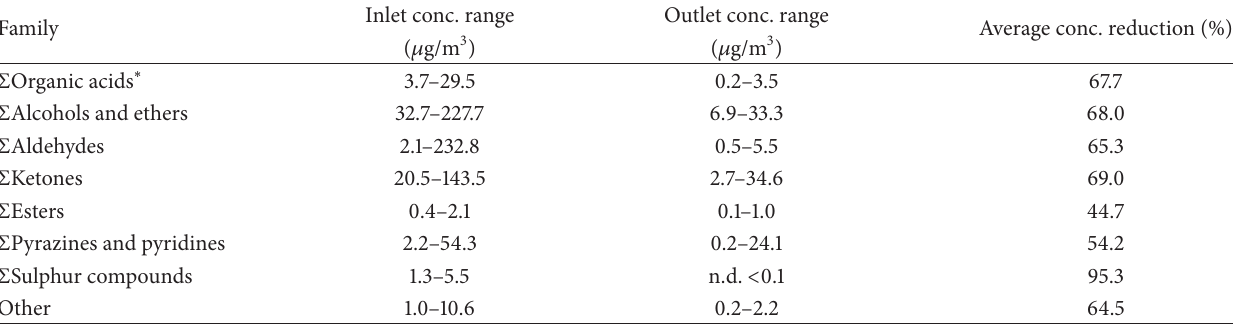
Table 3: Inlet and outlet concentration ranges and average concentration reduction for each compound family.